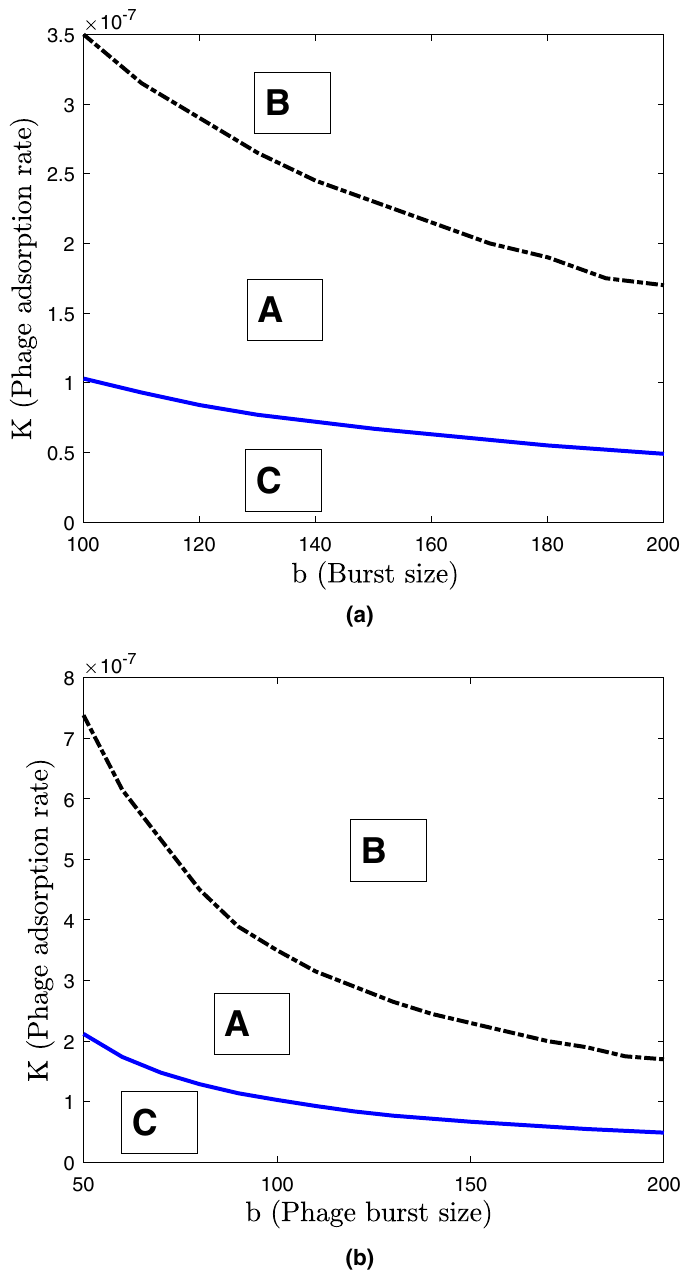
Figure 8. Bifurcation diagrams showing dynamical regimes in the model (Nakhon Phanom province) depending on the parameters µ (the morality rate of phages)- C surf (carrying capacity on the surface) and K (overall phage adsorption rate) and b (phage burst size). The classification of regimes A–C is the following. Regime “A” corresponds to periodic daily variations of species densities; for regime “B” species shows irregular oscillations; regime “C” signifies the extinction of phages. Other model parameters are set at default